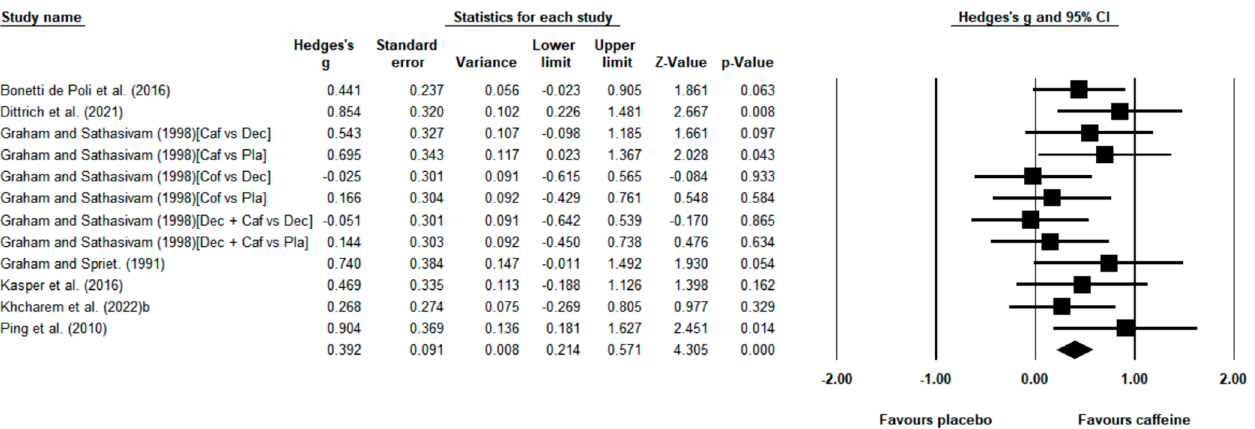
Figure 2. Risk of bias summary: determination of the risk of bias items for included studies. (+) = low risk of bias; (?) = unclear risk of bias. A total of 21 papers [7,23–26,30,34,35,42–54] were re- viewed .